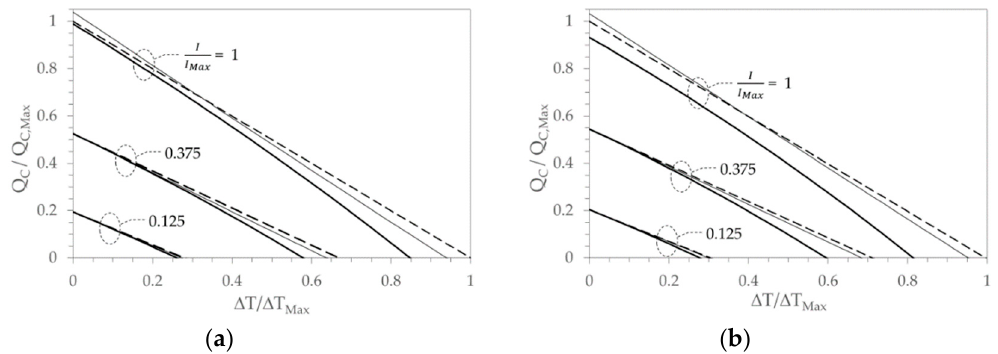
Figure 9. 𝑇 (cid:3009) = 298.15 𝐾 . Relative cooling capacity 𝑄 (cid:3004) /𝑄 (cid:3014)(cid:3028)(cid:3051) against the relative temperature Figure 9. T H = 298.15 K . Relative cooling capacity Q C / Q Max against the relative temperature di ff erence ∆ T / ∆ T ff erent relative feeding currents I / I difference Δ𝑇/Δ𝑇 (cid:3014)(cid:3028)(cid:3051) for different relative feeding currents 𝐼/𝐼 (cid:3014)(cid:3002)(cid:3025) . The thick solid lines represent the Max for di MAX . The thick solid lines represent the performed performed experiment; the dashed lines refer to thermoelectric properties independent of experiment; the dashed lines refer to thermoelectric properties independent of temperature, the thin temperature, the thin solid lines indicate the scenario in which the Seebeck coefficient depends on the solid lines indicate the scenario in which the Seebeck coe ffi cient depends on the temperature, while temperature, while both the electrical resistivity and the thermal conductivity are temperature both the electrical resistivity and the thermal conductivity are temperature independent: ( a ) case ( i ); Metals 2020 , 1 , x FOR PEER REVIEW ( b ) case ( ii ). independent: ( a ) case ( i ); ( b ) case ( ii ).